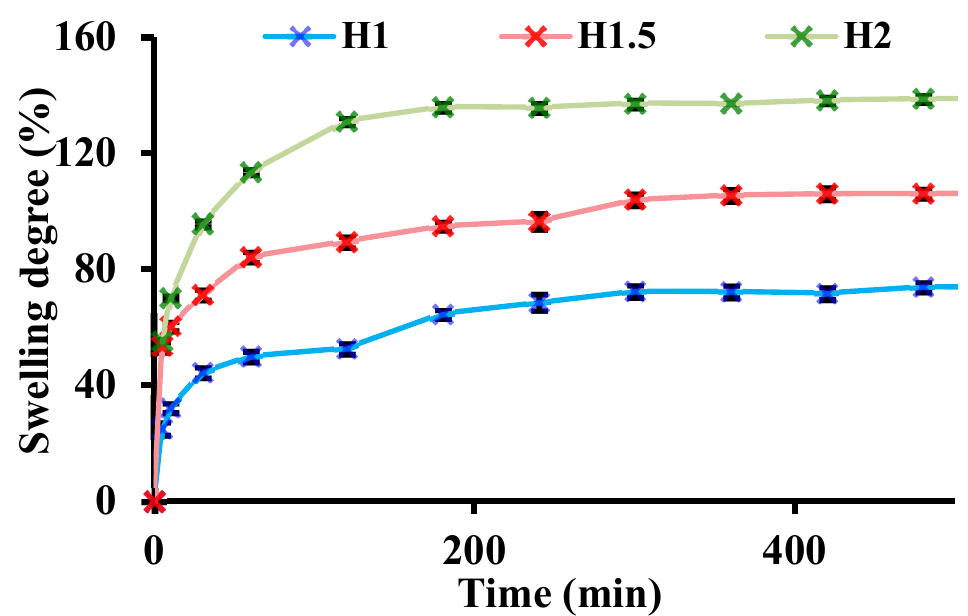
Figure 4. The swelling kinetics of the reference hydrogels in